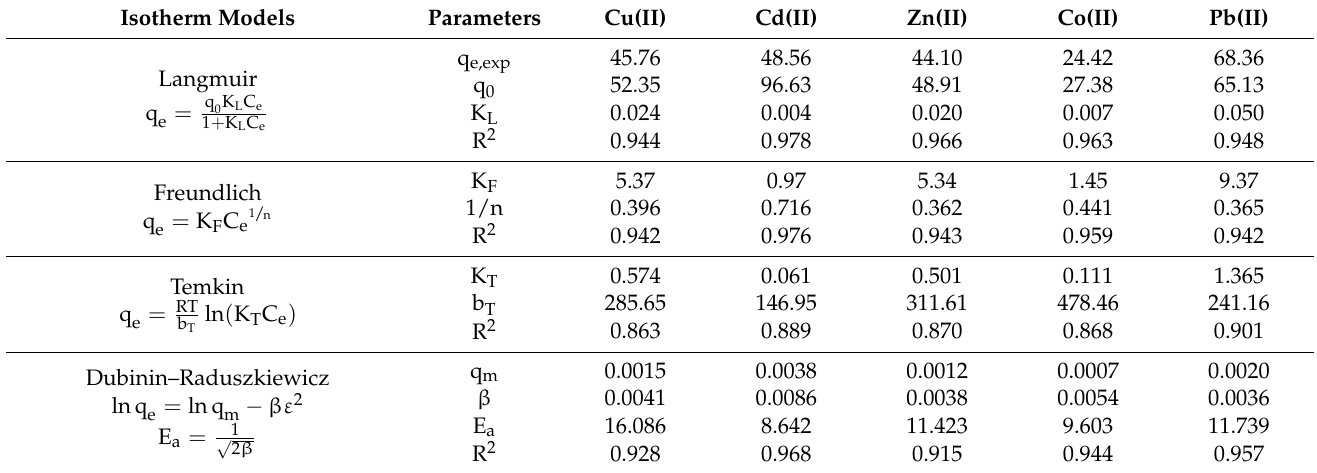
Table 4. Adsorption isotherm parameters and correlation coefficients for the adsorption of Cu(II), Cd(II), Zn(II), Co(II) and Pb(II) on BC-CS